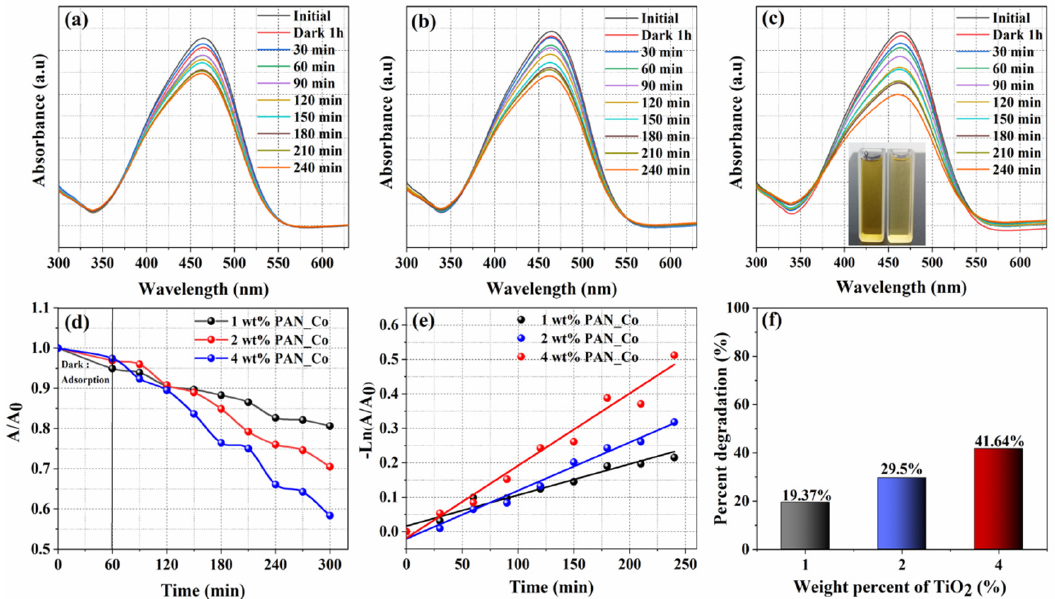
Figure 9. Photocatalytic activity of PAN_Co NFs membrane with different wt% of TiO 2 NPs. Spectrophotometer spectra at different time intervals and wt% of TiO 2 ( a ) 1 wt%, ( b ) 2 wt% and ( c ) 4 wt%. ( d , f ) degradation and ( e ) kinetics. The dose of photocatalytic membrane (60 mg) and concentration of the dye (20 ppm) were kept constant.